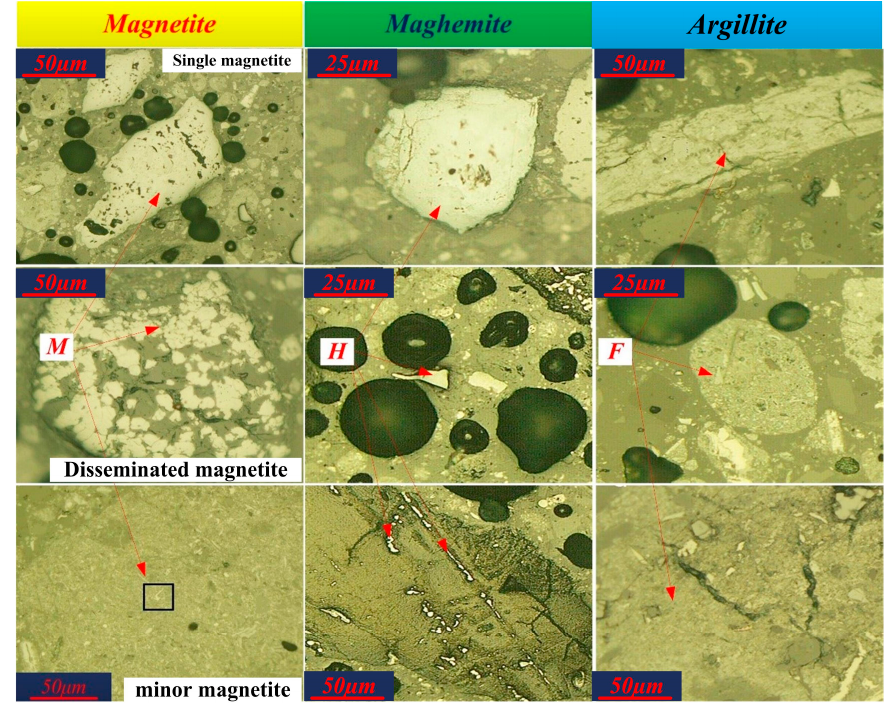
Figure 5. Photomicrographs of typical iron-bearing minerals textures in the slag: M—magnetite; H—maghemite; F—argillite.